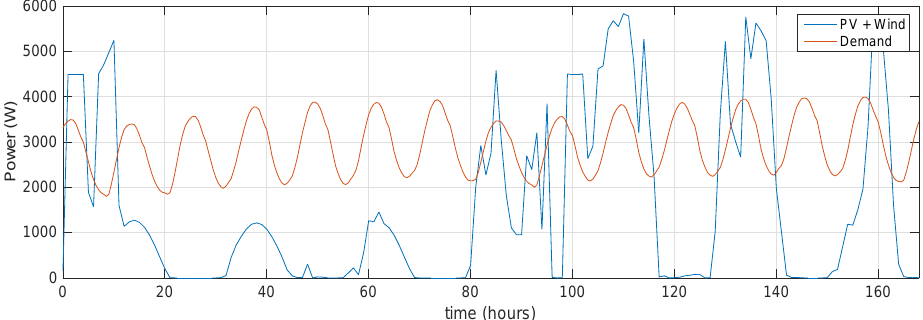
Figure 4. PV and wind turbine energy generation profile and load power